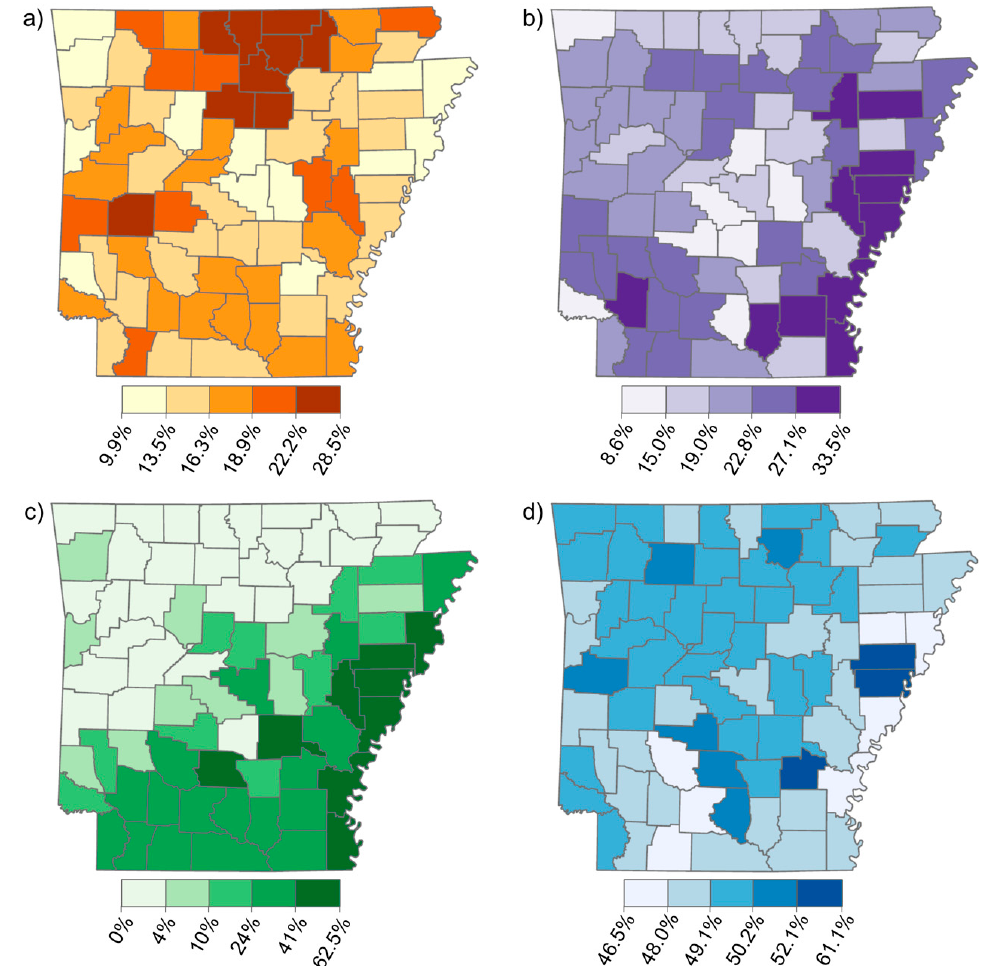
Figure 2. Maps of demographic variables as percentages of the population by county in AR: ( a ) Over age 65; ( b ) Living below the poverty line; ( c ) Black race; and ( d ) Male gender.